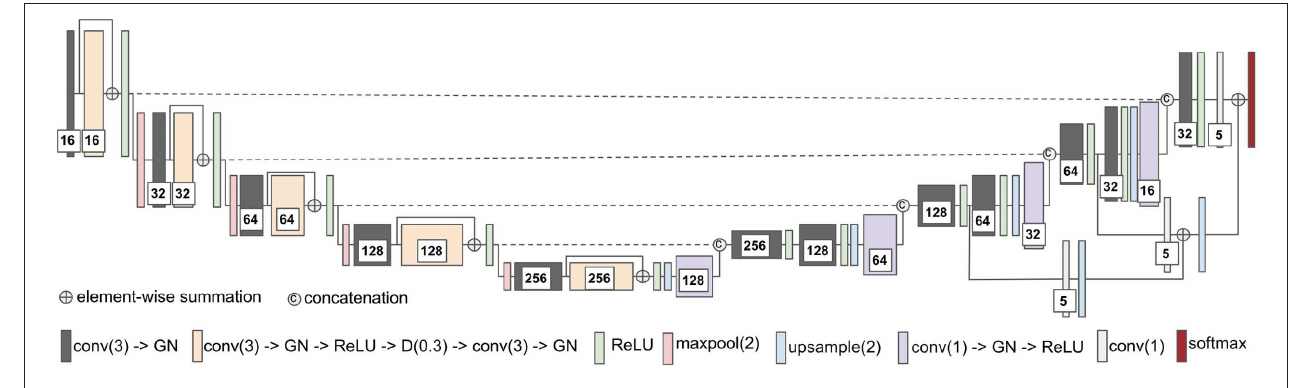
FIGURE 2 | The network architecture of modified 3D U-Net. conv(3), 3 × 3 × 3 convolutional layer; GN, group normalization; D(0.3), dropout layer with 0.3 dropout rate; maxpool(2), 2 × 2 × 2 max pooling layer; and conv(1), 1 × 1 × 1 convolutional